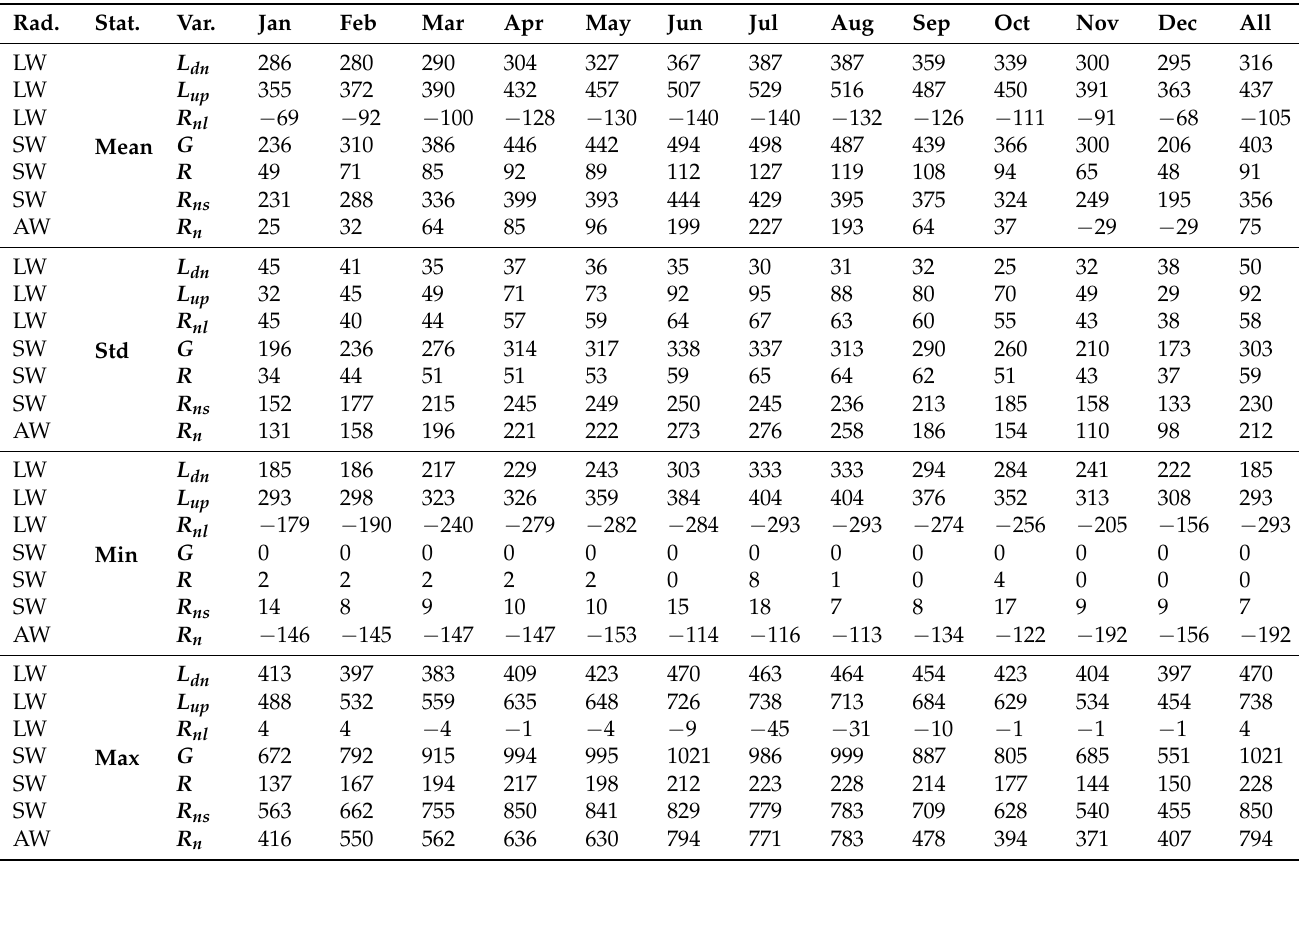
Table 4. Monthly statistics of longwave (LW) and shortwave (SW) irradiances and their associated standard deviations (Std) and extreme values in W/m 2 .